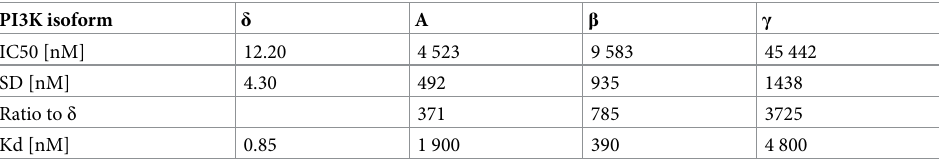
Table 1. CPL302-253 selectivity and potency in kinase assays. The CLP302-253 IC50 for the enzymatic activity of recombinant α , β , γ and δ PI3K isoforms was determined in ADP-Glo Kinase assay. The assay was performed at least 3 times. The CPL302-253 binding affinity was assessed in KINOMEScan competitive binding assay. Kd were calculated with a standard dose-response curve using the Hill